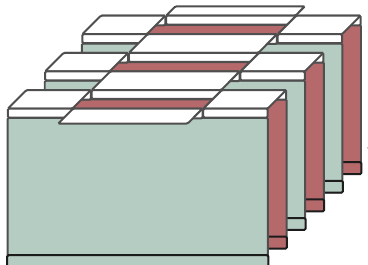
Figure 1: Pictorial representation of tr corresponding to A and ¯ A are connected together in a “staggered” fashion: this stag- gering is implemented the operators